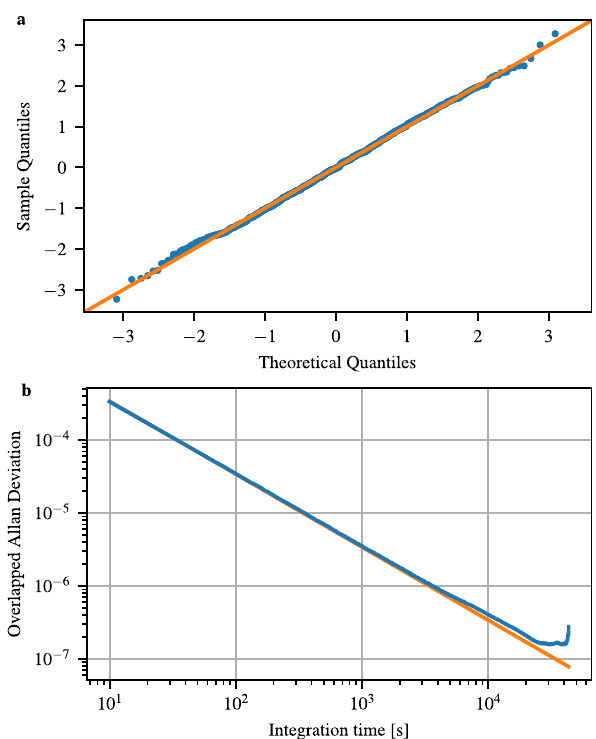
Fig. 6 Veri fi cation of assumption A2. a Quantile – quantile plot indicating the Gaussianity of the measured samples. The variance of the samples has been normalized to 1. The limited analog-to-digital converter range truncates the tails of the Gaussian distribution, which results in slight deviations from the theoretical quantiles toward the ends. b Overlapped Allan deviation of vacuum state measurements. The stationarity condition is ful fi lled when the experimental points follow the theory curve, which is the case until about 1000s where it starts to